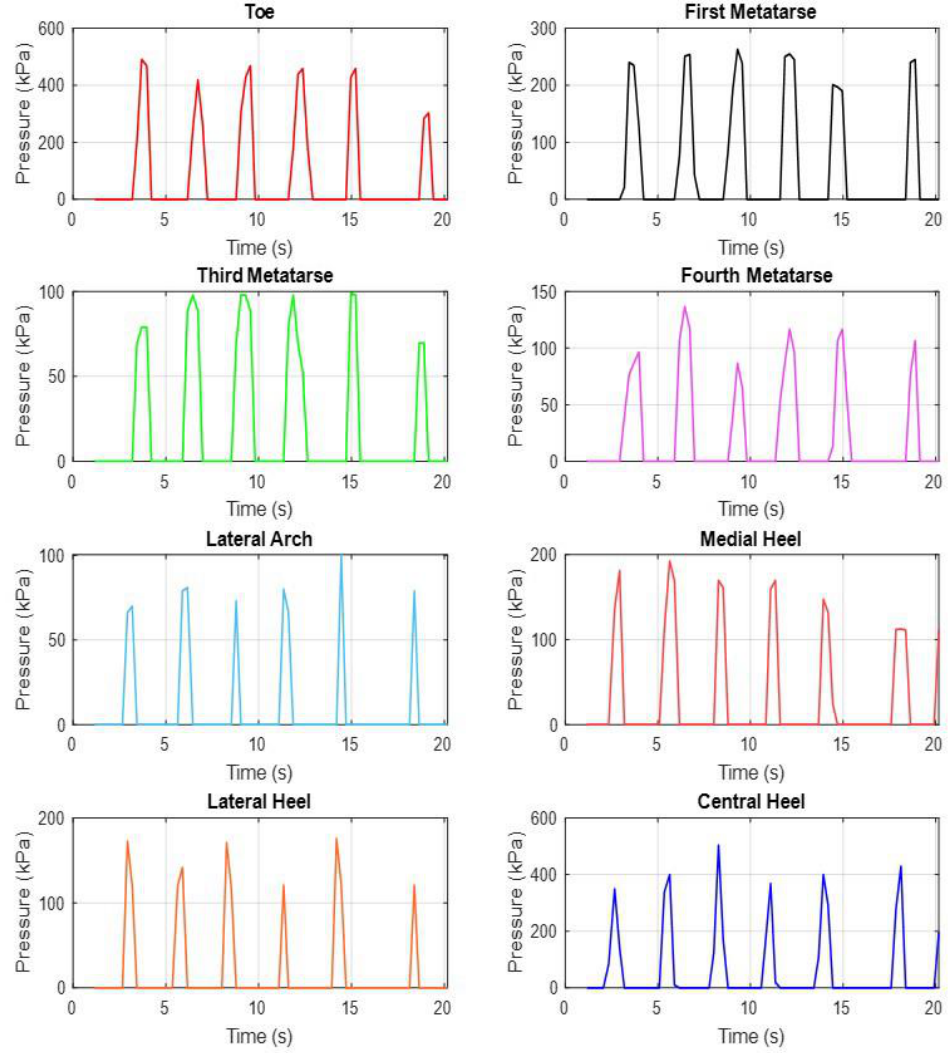
Figure 11. Peak planter pressure for each point.